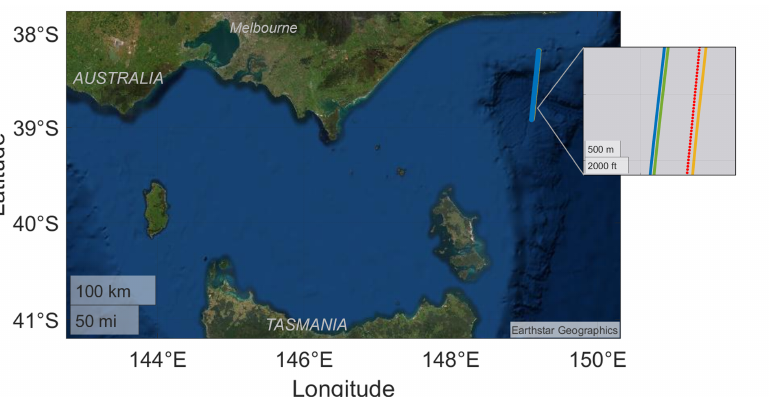
Figure 2. Map of the location of the track from the MIR transect (yellow), CryoSat-2 (red), and the specular reflections position of the GPS PRN 3 (green) and Galileo E08